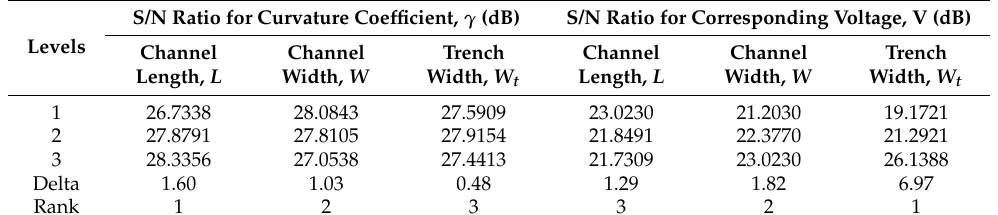
Table 7. Response table of S/N ratio for the curvature coefficient γ and corresponding voltage V.